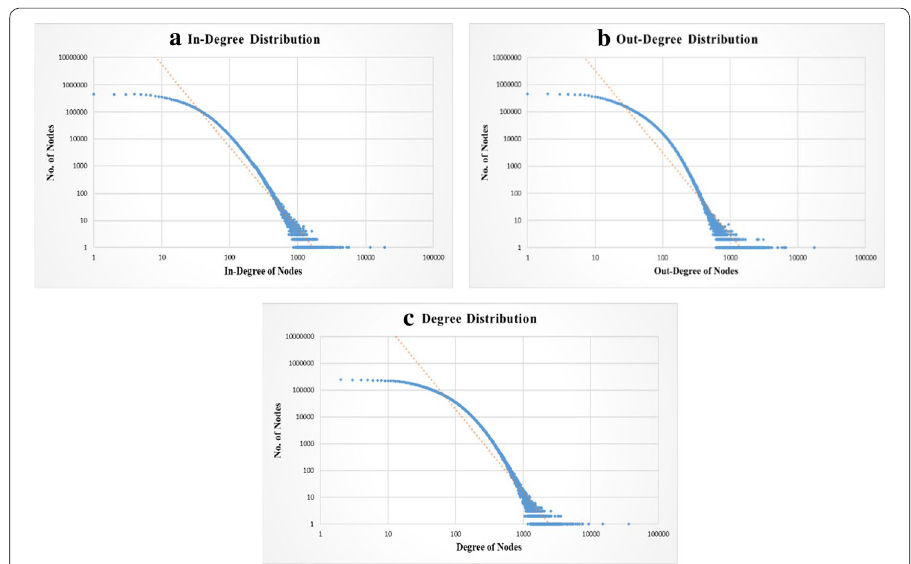
Fig. 4 Frequency distribution of degrees